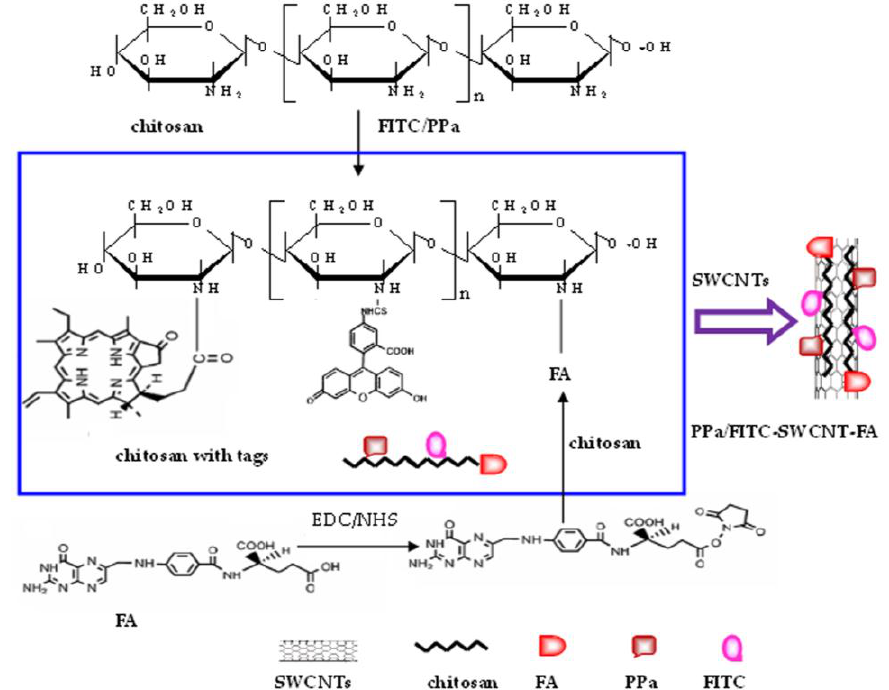
Figure 1. Synthetic scheme of the targeting theranostic nanoprobe based on folic acid (FA), pyropheophorbide a (PPa), fluorescein isothiocyanate (FITC), and chitosan pyropheophorbide a (PPa), fluorescein isothiocyanate (FITC), and chitosan (CHIT)-comodified single-walled carbon nanotubes (SWCNTs).